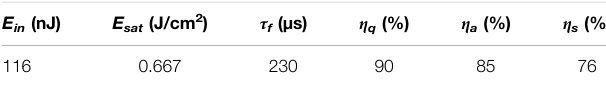
TABLE 1 | Basic parameter values used in the